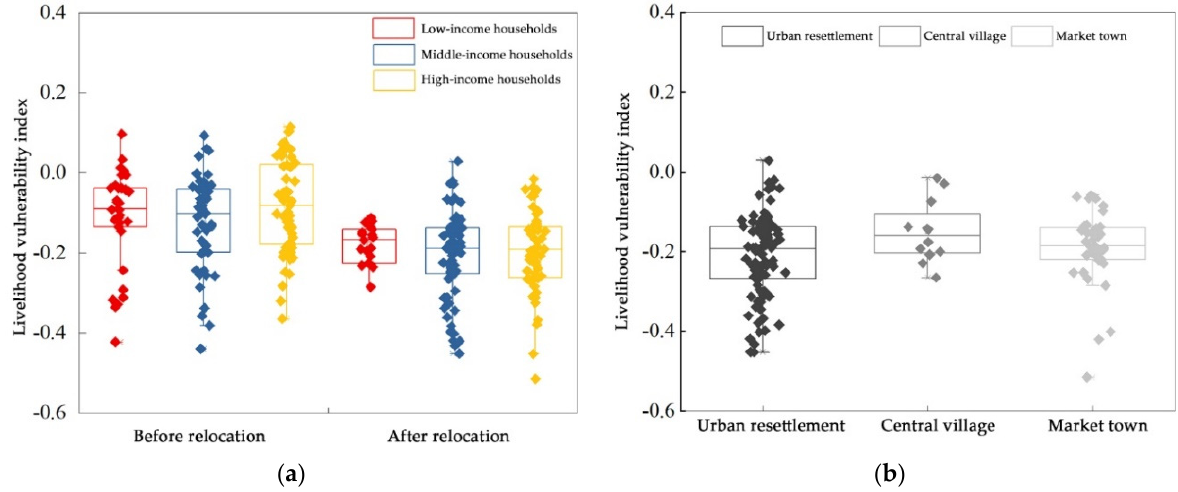
Figure 2. Livelihood vulnerability index of households with different income types and resettlement methods.